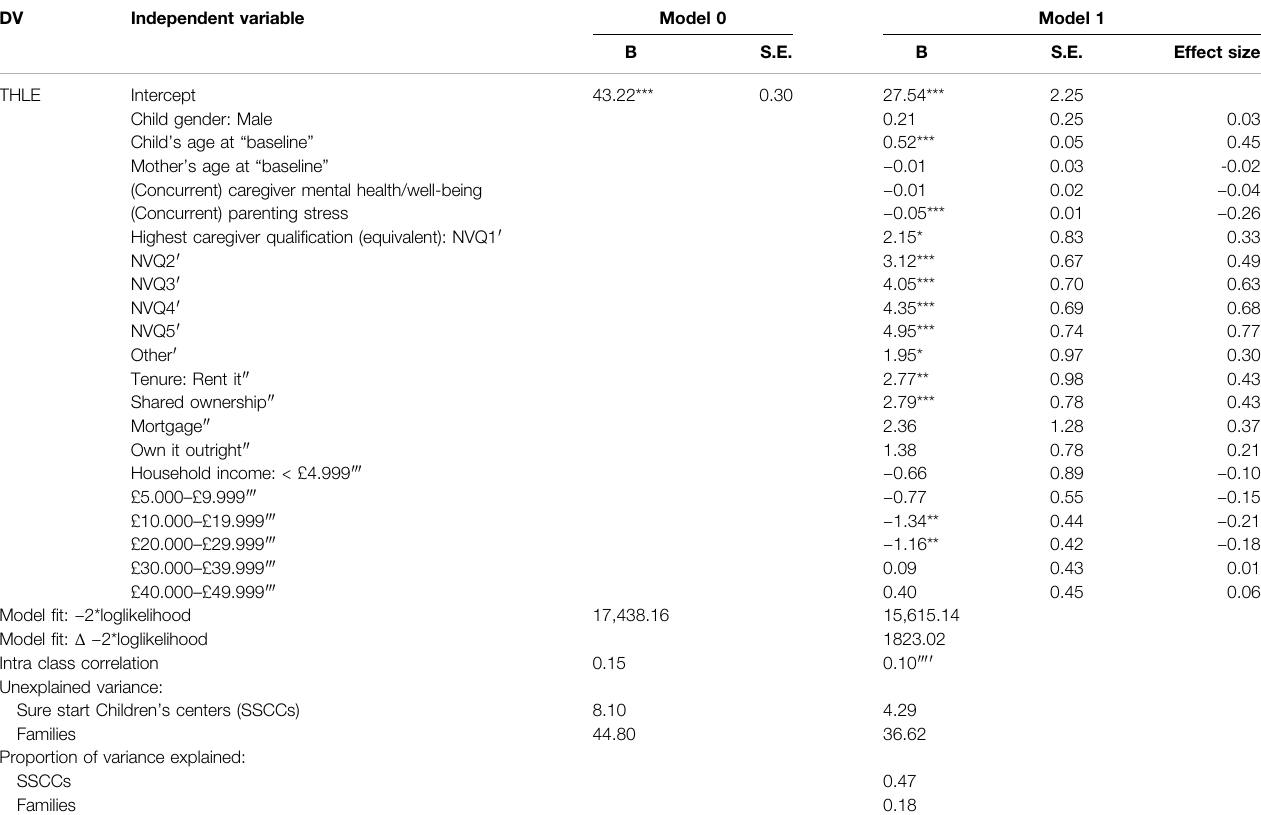
TABLE 6 | Multilevel regression showing associations between demographics and the toddler home learning environment scale (THLE; n (cid:1) 2,404 of the longitudinal n (cid:1) 2,608).